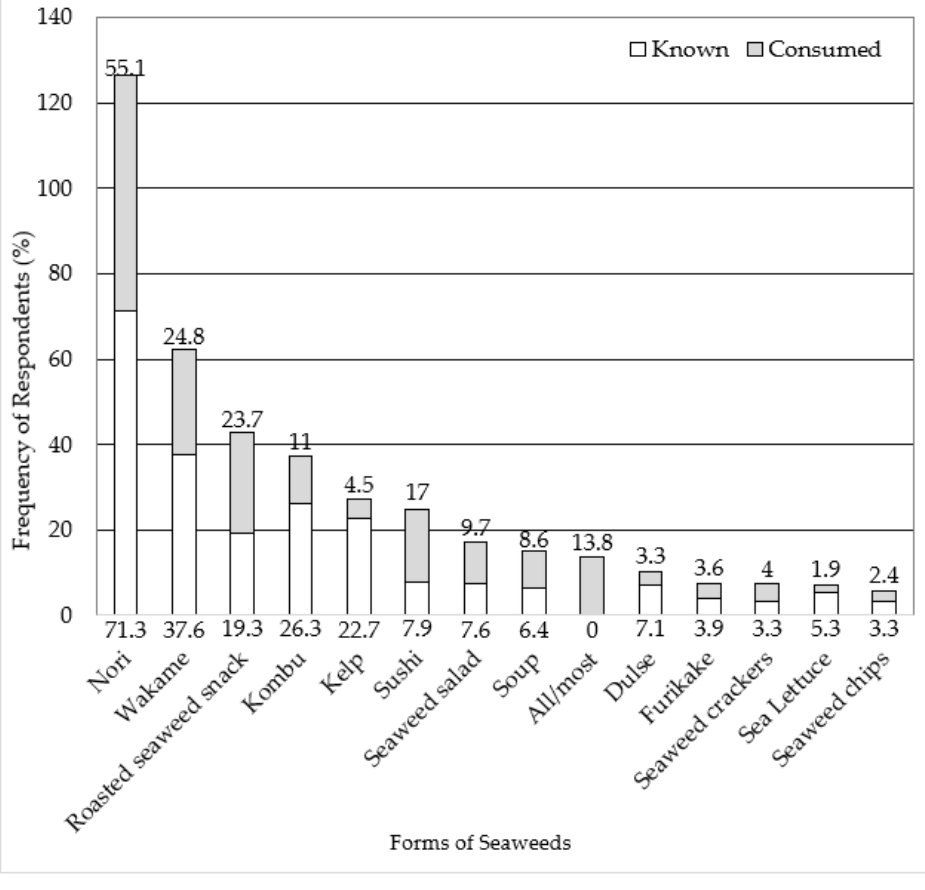
Figure 2. Forms of seaweed known and consumed, as reported by participants. The varieties are presented in descending order from most to least reported, cumulatively, of both known and consumed responses. The data labels are representative of the percentage of respondents.